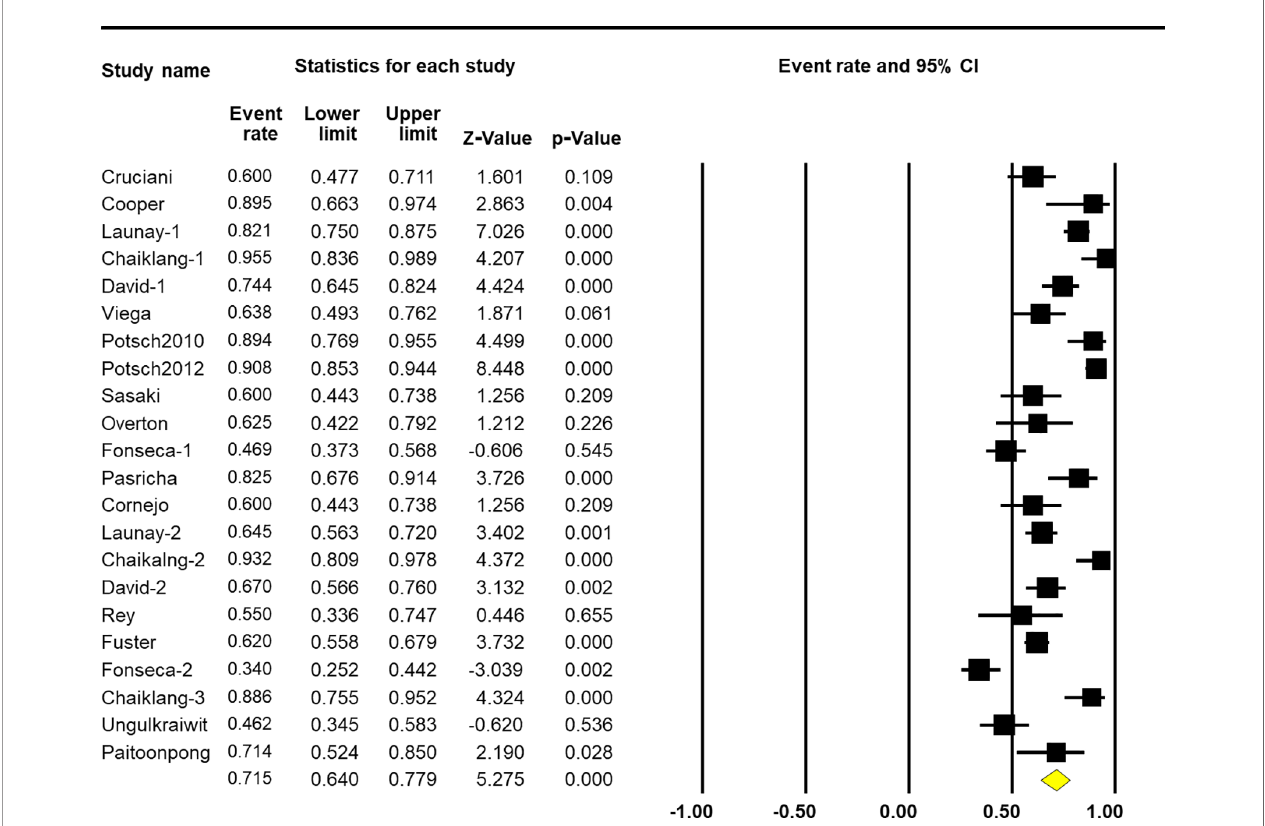
FIGURE 2 | Overall ef fi cacy of hepatitis B virus (HBV) vaccination on the response rate.